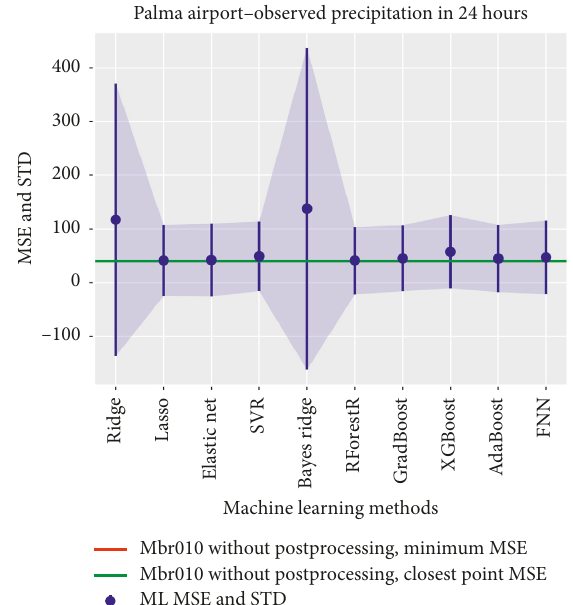
Figure 20: Precipitation in 24hours, calibration plot for Palma airport. Horizontal axis as in Figure 18.